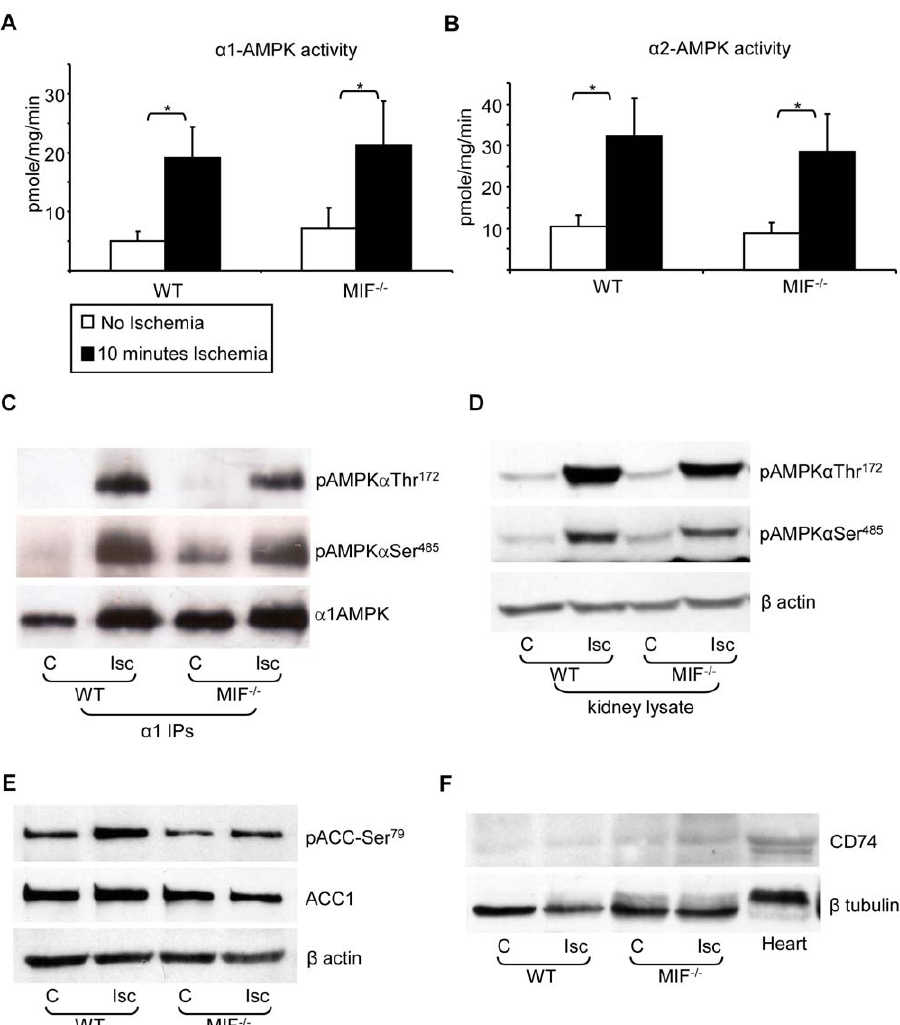
Figure 6. AMPK activation and phosphorylation after acute renal ischemia in MIF 2 / 2 mice. Lysates (1 mg protein) from control ( % no ischemia) and ischemic ( & 10 min ischemia) kidneys of WT (C57Bl/6) and MIF 2 / 2 mice were immunoprecipitated with antibodies specific for the a 1 (A) and a 2 (B) AMPK catalytic subunits (n=10–12 per group for a 1 and n=6 for a 2). AMPK activity was measured by ADR-1 peptide activity assay. Results are shown as mean 6 SD. a 1-AMPK and a 2-AMPK activity were increased several fold after 10 minutes ischemia in WT and MIF 2 / 2 mice (* P , 0.001). There were no differences in a 1-AMPK or a 2-AMPK activity between WT and MIF 2 / 2 under either control or ischemic conditions. C. Lysates (1 mg protein) from control (C) and ischemic (Isc) kidneys of WT and MIF 2 / 2 mice were immunoprecipitated with antibodies specific for the a 1 AMPK catalytic subunit and analyzed by Western blotting using antibodies against pAMPK a Thr 172 , pAMPK a Ser 485 and a 1AMPK (blot shown representative of 4 experiments). D. In addition, whole kidney lysates (50 m g) from the same experiment were separated by SDS-PAGE and analyzed by Western blot for AMPK phosphorylation at a Thr 172 and a Ser 485 , with blotting for b -actin as a loading control (blot shown representative of 4 experiments). E. Kidney lysates from this experiment were blotted for inhibitory phosphorylation of ACC at Ser 79 and expression of total ACC1 (blot shown representative of 4 experiments). F. Heart and kidney lysate was blotted for expression of the MIF receptor CD74.